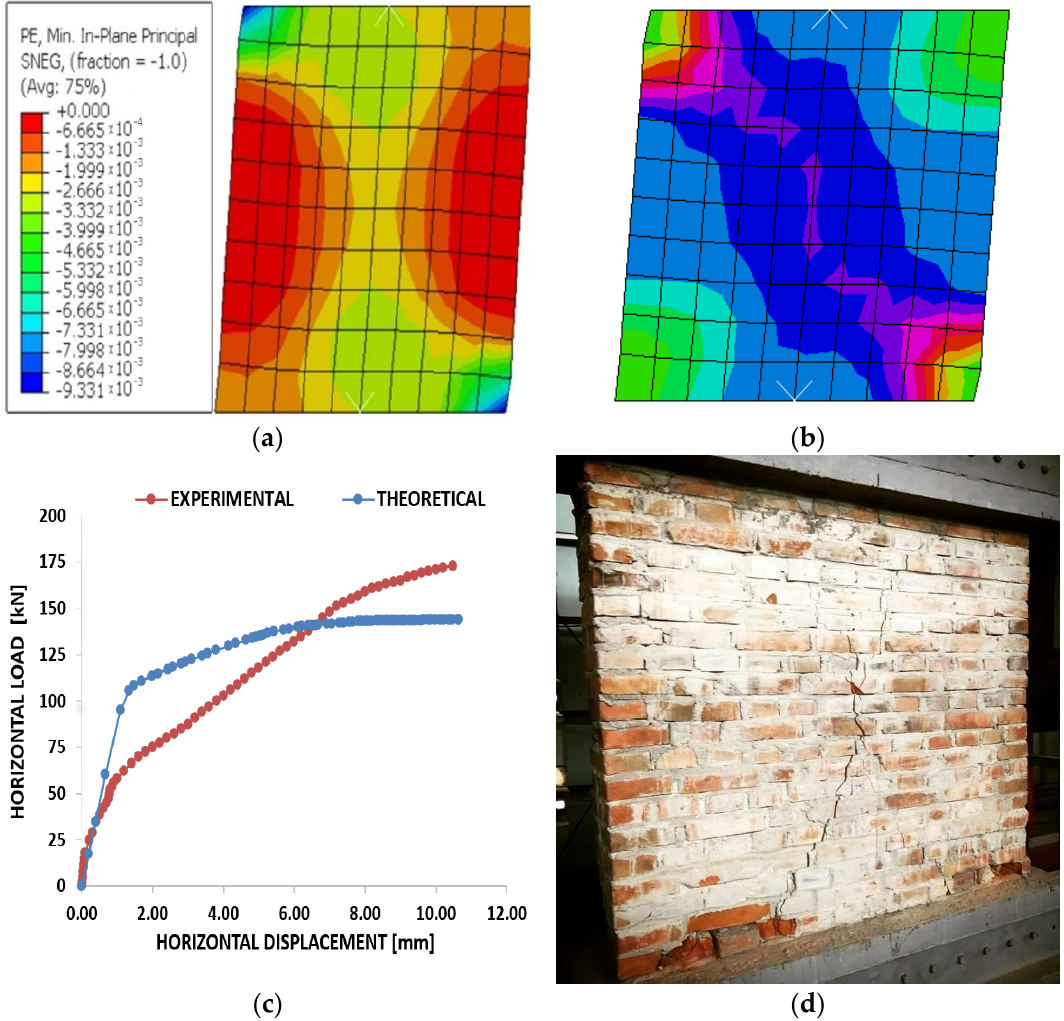
Figure 3. Compression plastic strain ( a ); strain components at integration point ( b ); graph of force– displacement to URM experimental and theoretical ( c ); failure mode of wall of solid brick masonry from the experimental program ( d ).